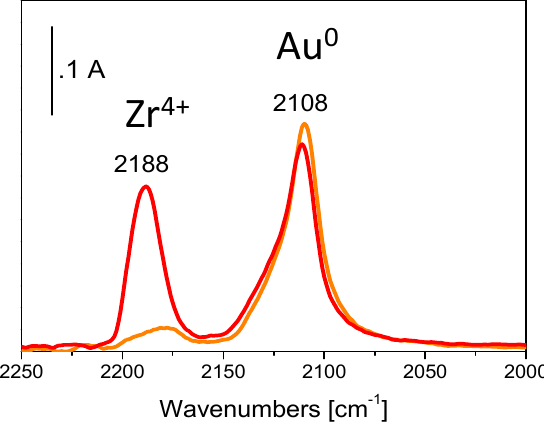
Figure 8. FTIR difference spectra collected upon the inlet of 15 mbar CO at room temperature on Au/ZrO 2 calcined at 500 °C after reactivation in O 2 at 250 °C (orange curve) and at 450 °C (red curve).